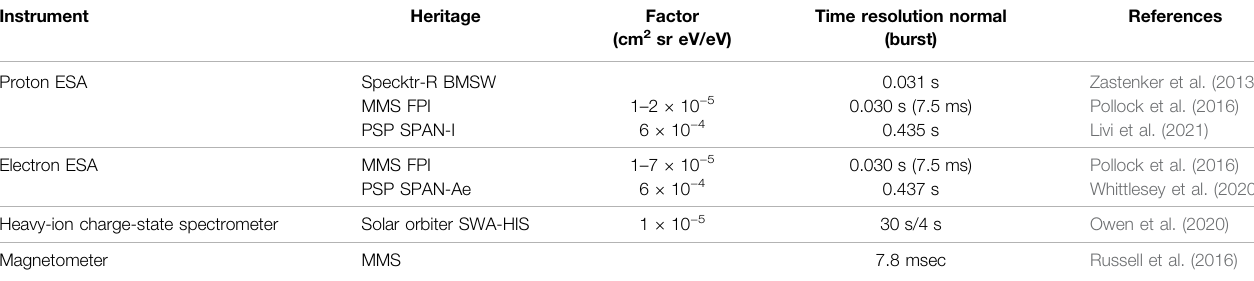
TABLE 2 | The current state of the art in ion and electron instrumentation. All are ESA based except the faraday cups of BMSW.